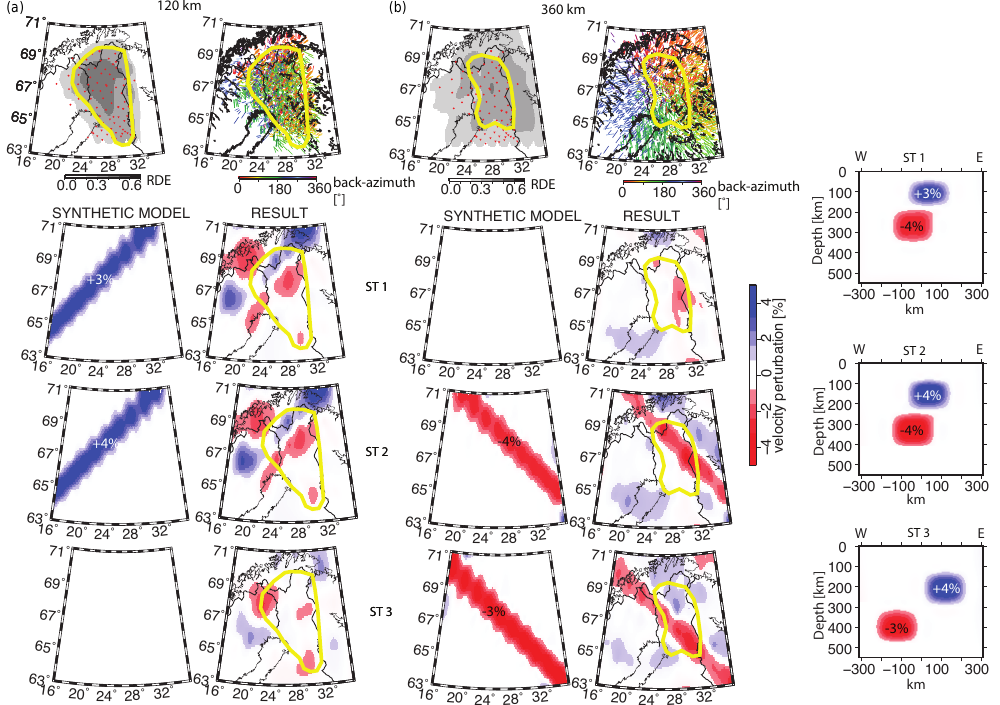
Figure 8. Two examples of data used to evaluate the lateral resolution of the inversion results with our data set at depths of (a) 120km and (b) 360km. The evaluation was based on diagonal elements of the resolution matrix (RDE) in the upper left corner of both subplots but also on ray coverage, shown in the upper right corner of both subplots, and the three synthetic test ST1, ST2, and ST3. Red dots and triangles in RDE plots show the locations of the POLENET/LAPNET and SVEKALAPKO stations, respectively, and the yellow line shows the boundary of the fairly well-resolved area. The boundary mostly follows a 0.3 RDE line but has occasionally been adjusted based on ray coverage and synthetic test results. In the right side of the figure, west–east vertical sections through the three synthetic models are shown, clarifying the location of the anomalous bodies in the vertical direction. The resolution analysis figures at all depths can be found in the